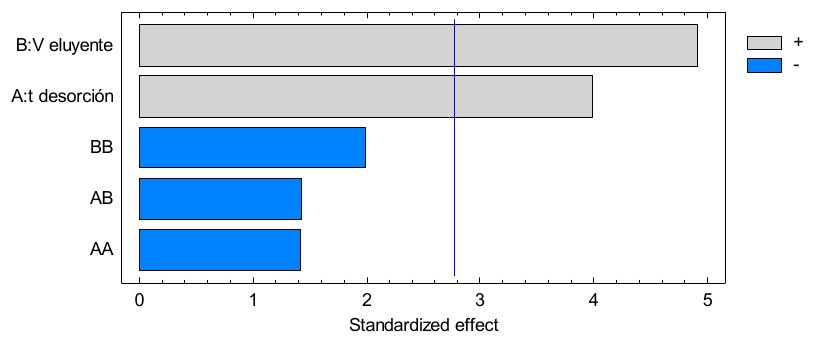
Figure 6. Standardized Pareto chart of the experimental design of the optimization.